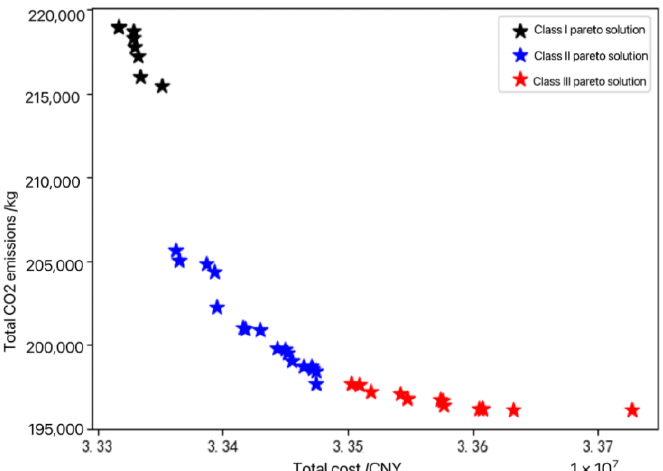
Figure 16. Classification of total cost and total carbon dioxide emissions (M = 3000) Pareto solution set.